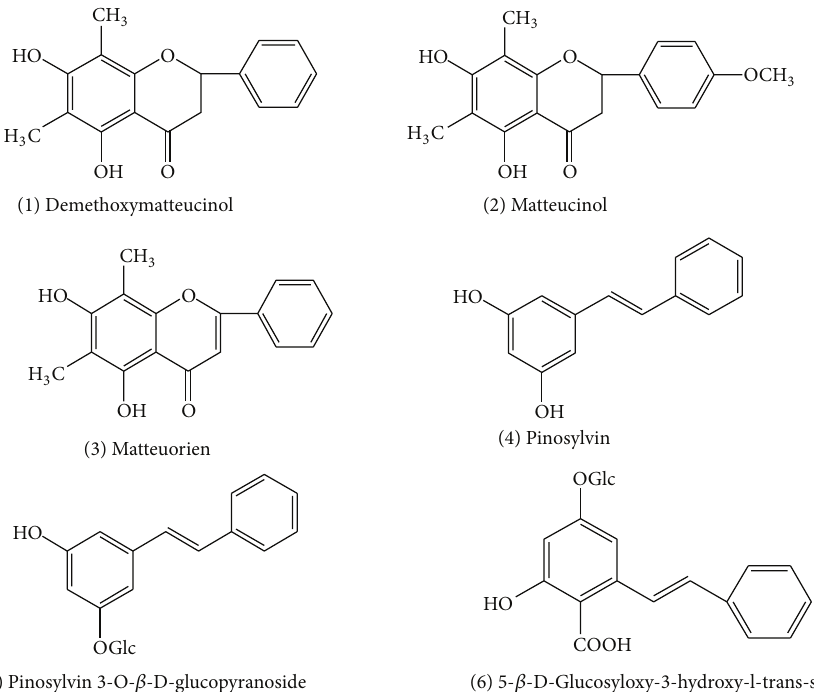
Figure 1: Structures of standard